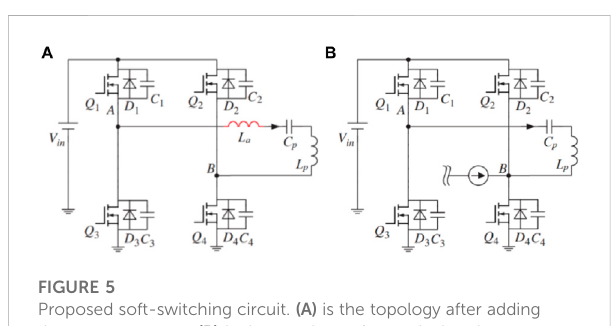
FIGURE 6 Waveforms of MOSFETs control signals, V AB, and i p for the proposed soft-switching